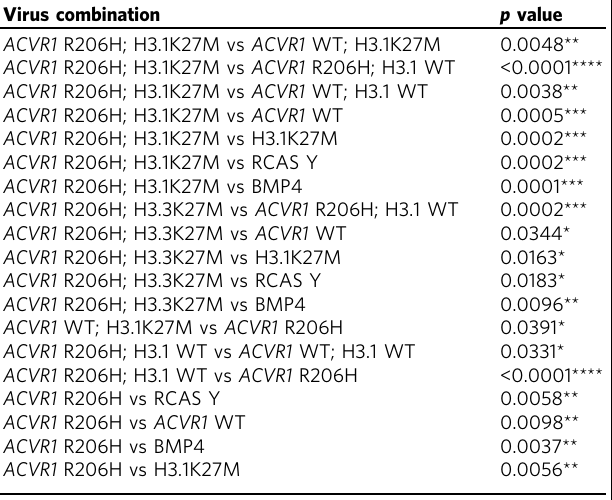
Table 2 ACVR1 R206H and H3.1K27M signi fi cantly increase tumor incidence Virus